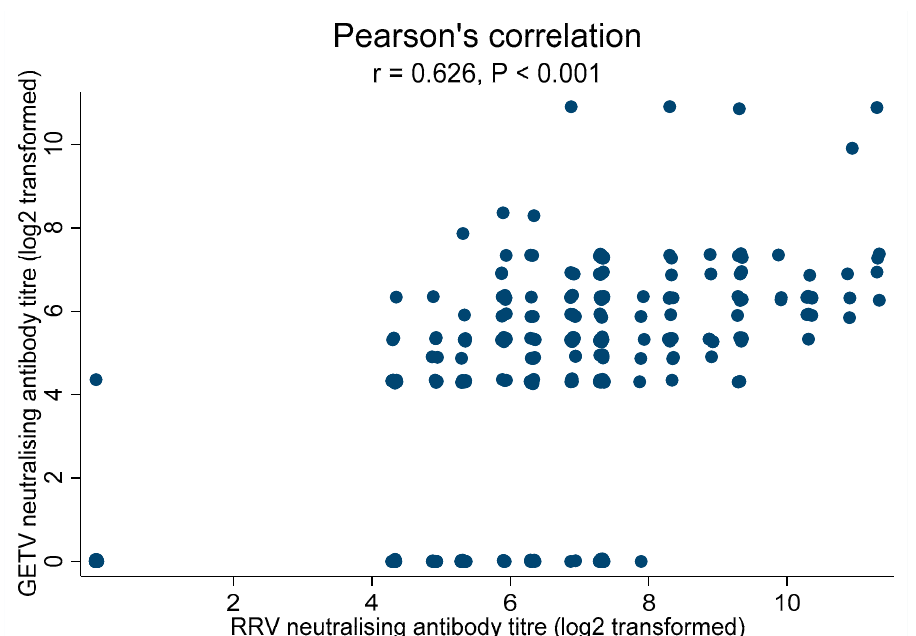
Figure 1. Correlation of neutralizing antibody titer (log 2 transformed) between RRV and GETV. The random noise effect was added to the same data points to prevent overplotting.